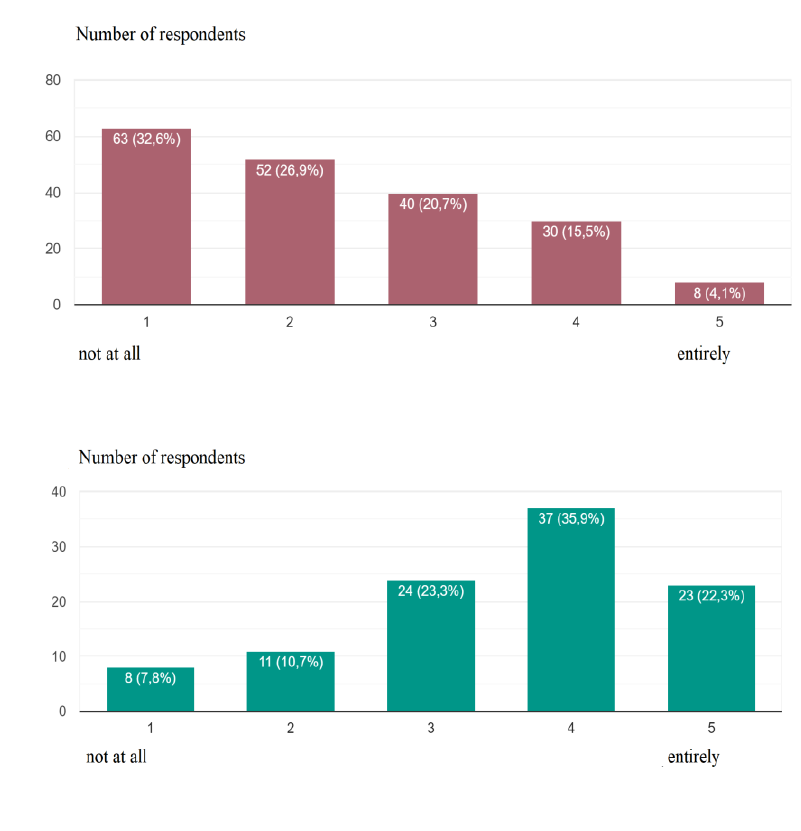
Fig. 5. Do you think the compulsory natural science subject at final exam improves the popu- larity of STEM